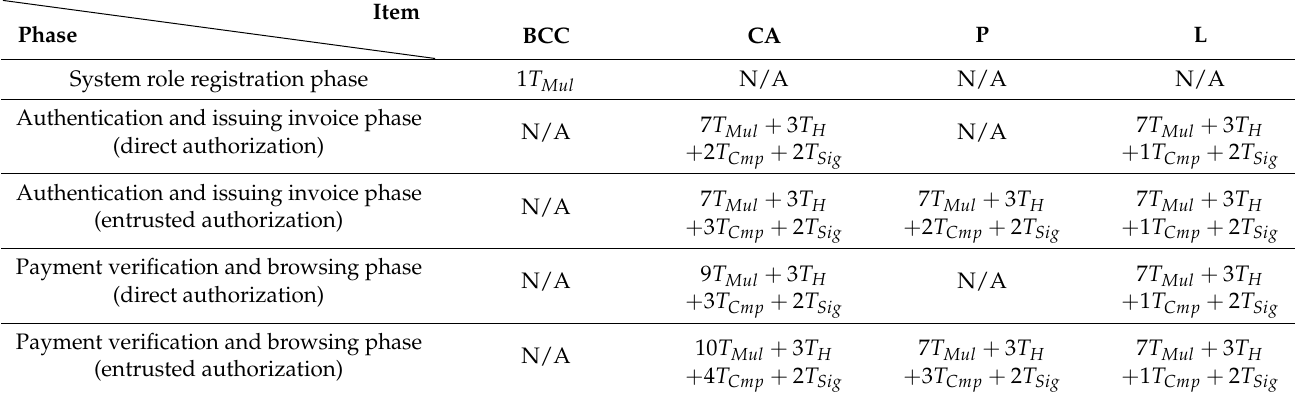
Table 2. Computation cost analysis of this